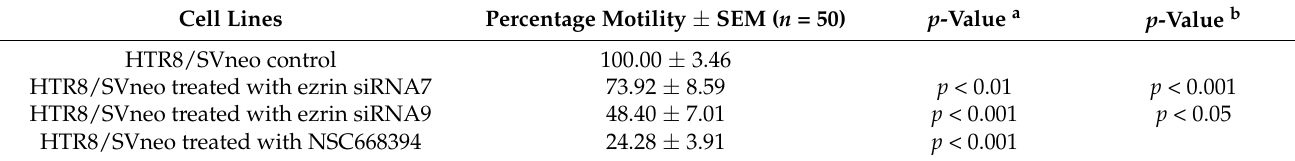
Figure 4. Reduced ezrin levels or its Thr567phosphorylation results in differential reductions in the cellular motility of HTR8/SVneo and Swan71 trophoblasts. HTR8/SVneo and Swan71 cells were incubated in the presence of different ezrin siRNAs or control siRNAs for 72 h ( A , D ) or treated with NSC668394 inhibitors for 24 h ( B , E ) prior to starvation with low-serum-containing medium. After 24 h, cells were seeded into Boyden chambers for 16 h prior to fixation and staining using the Diffquik histochemical kit for labelling of both nuclei and cytoplasm ( A , B , D , E ). Five random fields were quantified for each chamber. Data are presented as means ± SEM of 4 independent experiments relative to controls (percentage) from 4 replicate wells for each set of conditions. ** p < 0.01 or *** p < 0.001 compared to control and mock treatments (one-way ANOVA). Images of representative fields of motility/invasion assays were taken with the EVOS XL Cell Imaging System at x20 magnification. Bar corresponds to 100 μ m ( A , B , D , E ). For immunofluorescence after siRNA delivery for 48 h, incubation cells were seeded on fibronectin-coated coverslips and grown for a further 48 h before fixing. For the ezrin phosphorylation experiment, NSC668394 inhibitors were added for 24 h prior to fixation, permeabilisation, and staining for paxillin and actin. Cells were mounted and viewed using epifluorescence microscopy ( C , F ). Images on the last row correspond to the enlarged regions of the highlighted cells. Bar corresponds to 50 μ m in the wide views and 10 μ m in the zoomed-in regions. Table 3. Comparison of trophoblast motility after inhibiting ezrin using siRNA delivery or NSC668394 treatments.